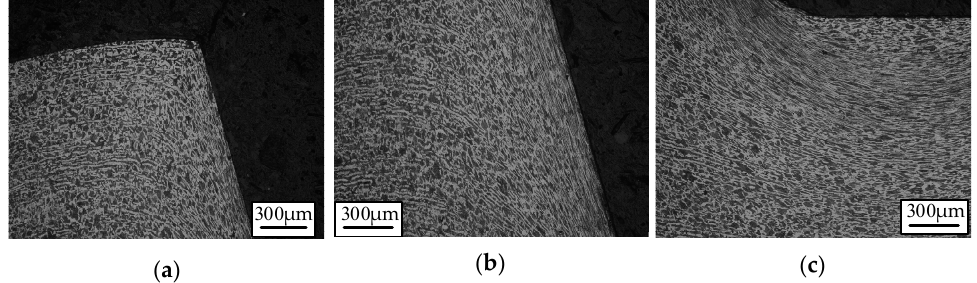
Figure 9. Metallographic structure of di ff erent parts of formed tooth groove: ( a ) Tooth top; ( b ) tooth wall; ( c ) tooth